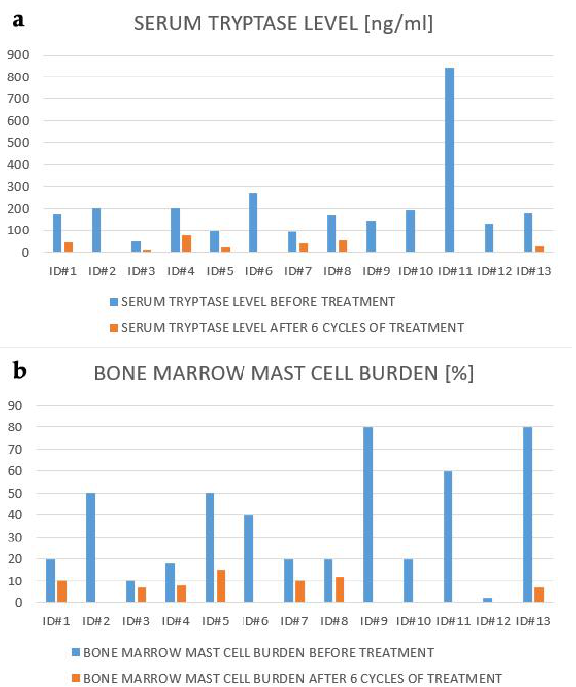
Figure 1. Clinicopathological measures of response: Serum tryptase level ( a ), bone marrow mast cell burden ( b ).